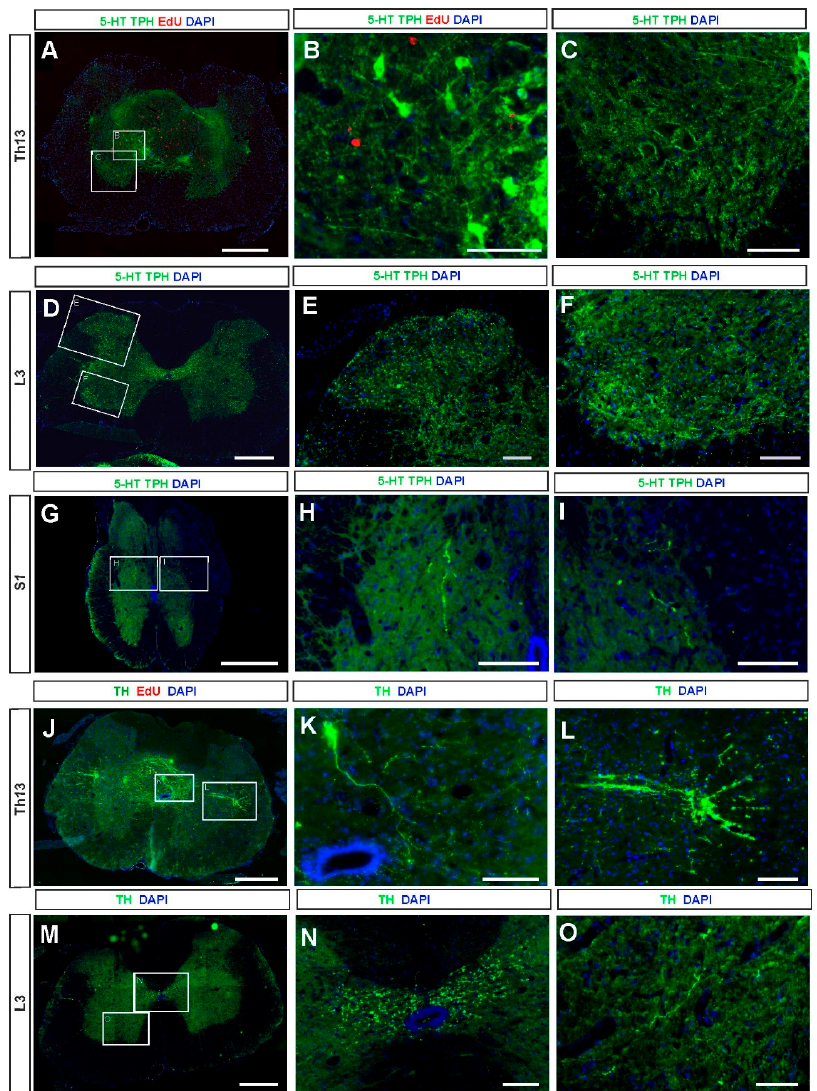
Figure 3. The 5-HT ( A – I ) and NA ( J – O ) neurons of graft origin and their axons innervating host spinal cord structures. Representative cross-section of the spinal cord at the epicenter of the graft